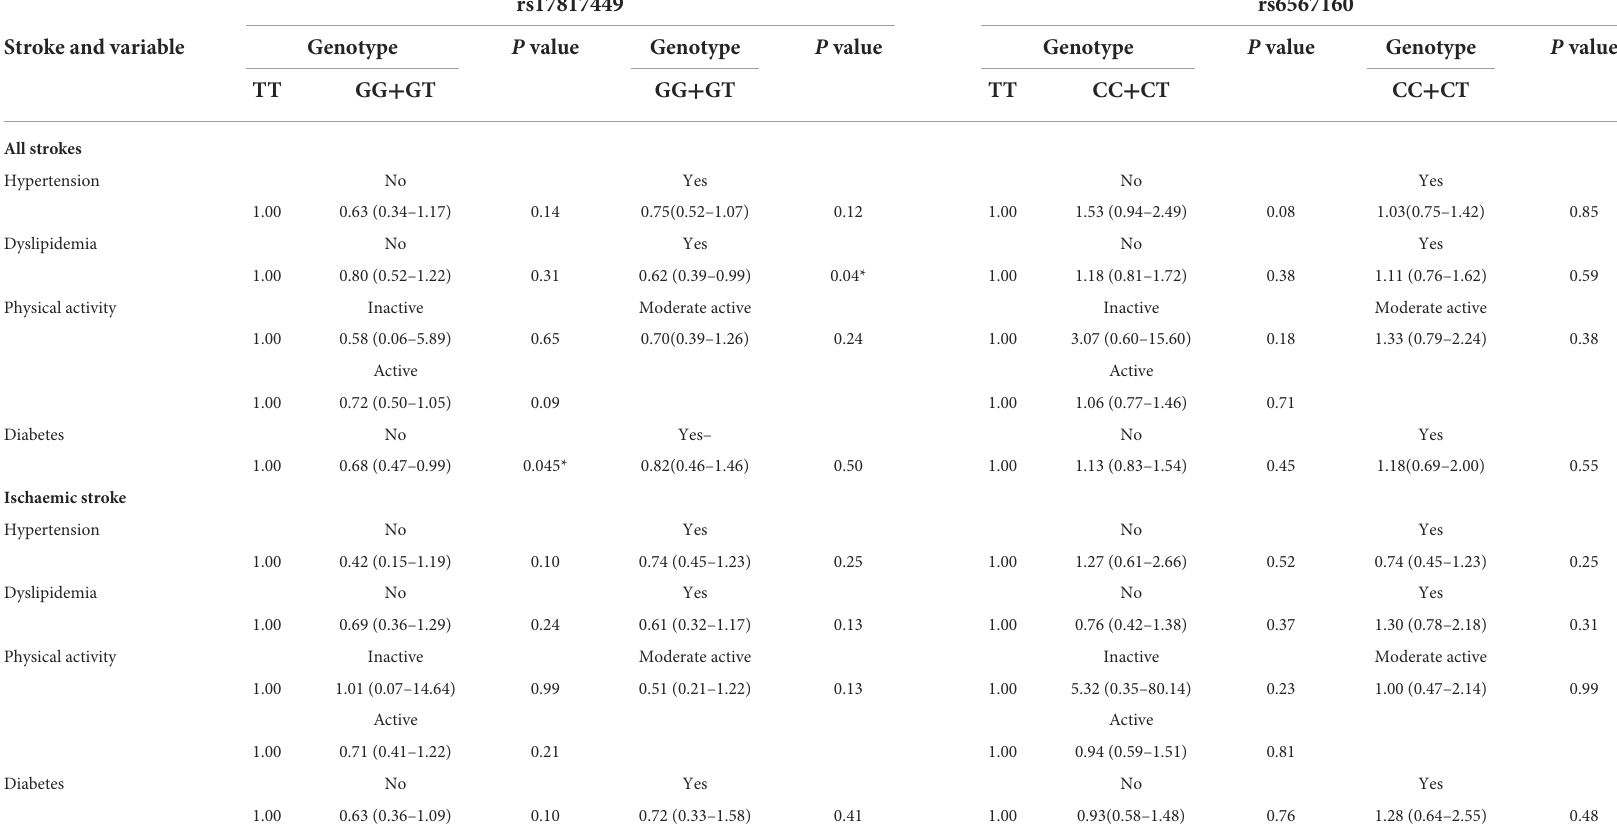
TABLE 6 Associations between rs17817449 and rs6567160 with the risk of stroke in stratified analyses on the G dominant model ( n =